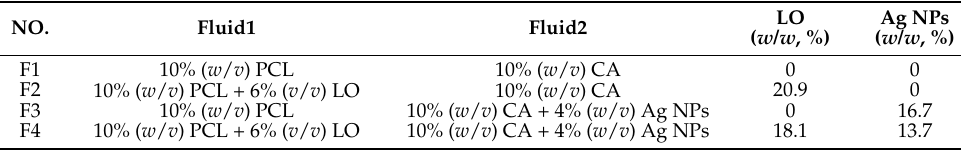
Table 2. Theoretical amounts of Ag NPs and LO in four different